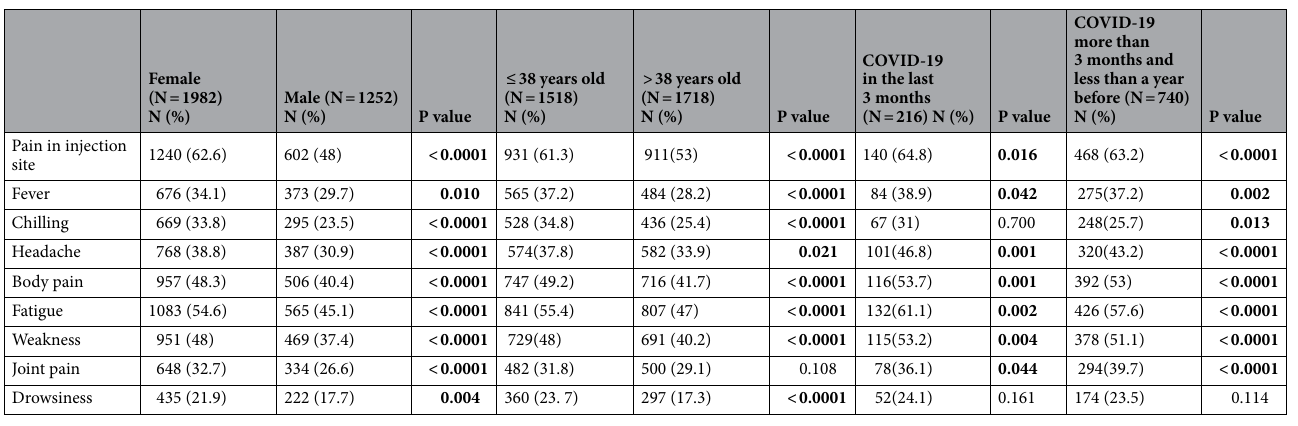
Table 3. The most common side effects of Sputnik V COVID-19 vaccine based on demographic features and past COVID-19. P value < 0.05 showed by boldface.